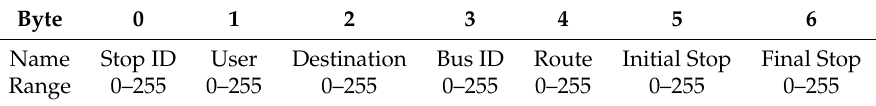
Table 2. MOVI-STOP-Rx data table received from MOVI-BUS and/or